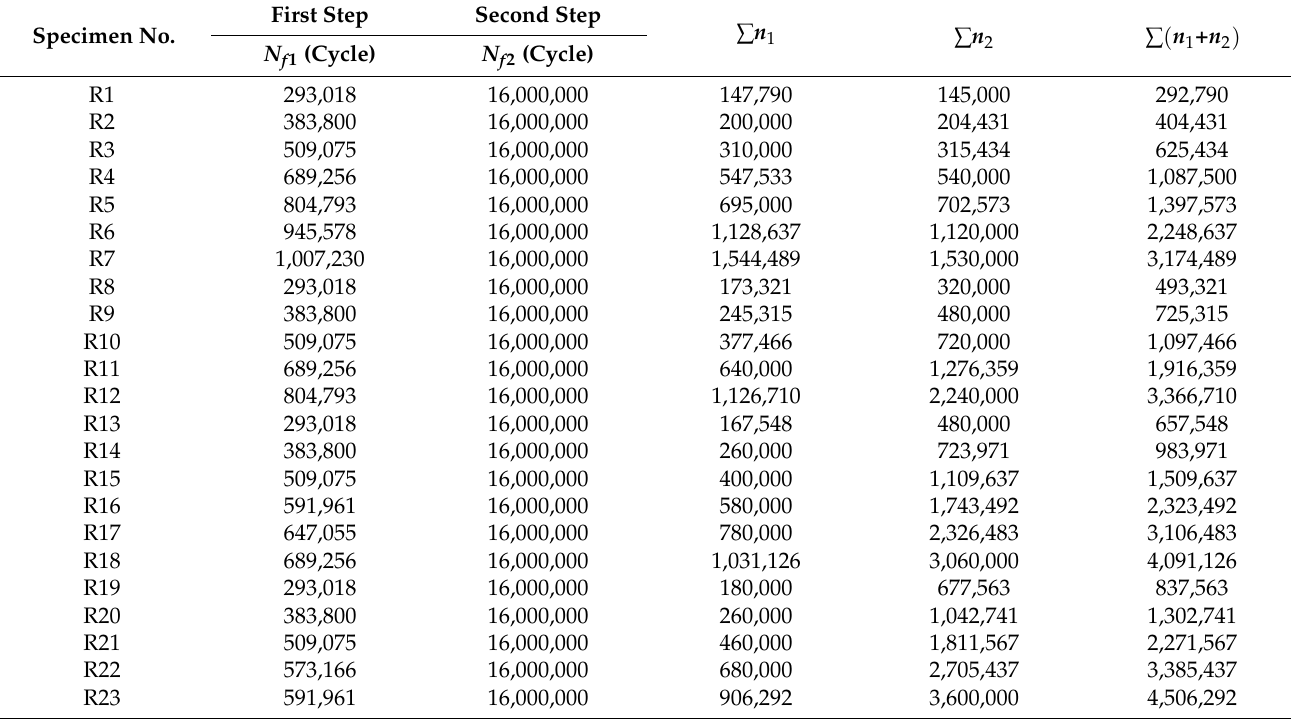
Table 6. The test results of designed T-type specimens under two-step repeating amplitude loading sequence. Specimen